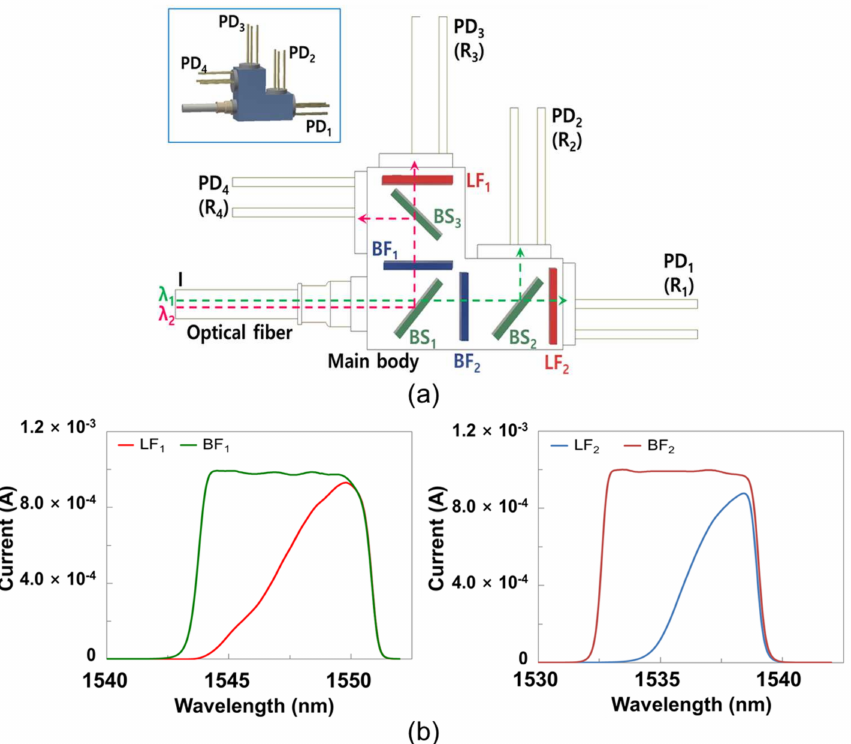
Figure 2. ( a ) A schematic view of a quad receiver (Quad-RX) module and ( b ) the current output characteristics of the linear filter (LF) and band-pass filter